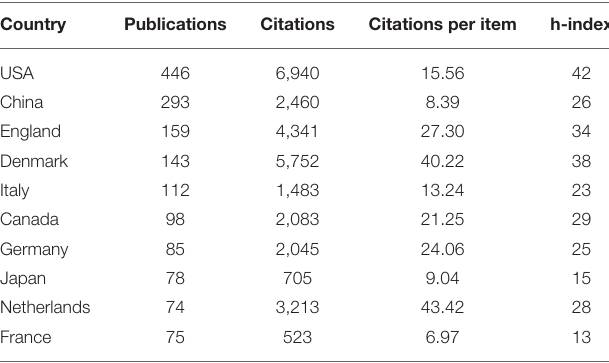
TABLE 1 | Top 10 countries with the greatest number of